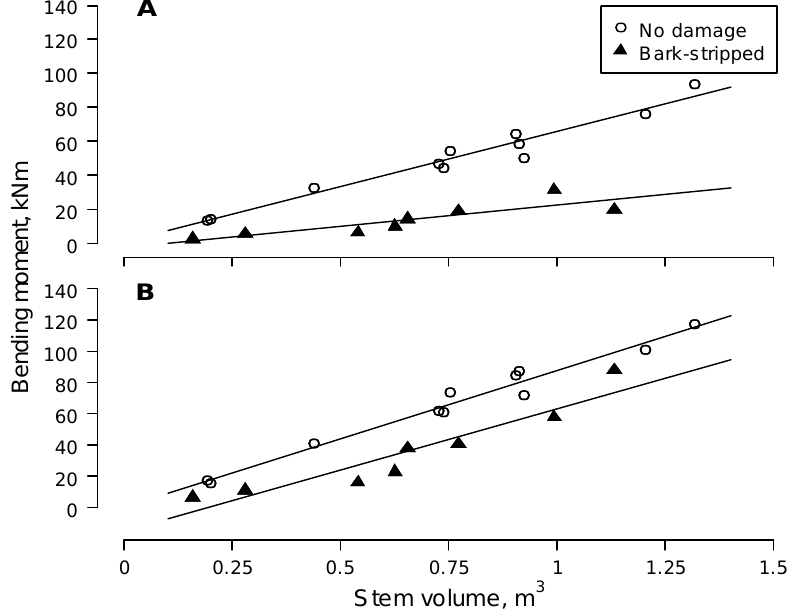
Figure 2. Bending moment of the Norway spruce stem at the primary failure ( A ) and secondary failure ( B ) according to stem–wood volume and presence of bark-stripping wound. Table 2. Regression between tree stability parameters and stem volume and cervid damage for the damaged trees.